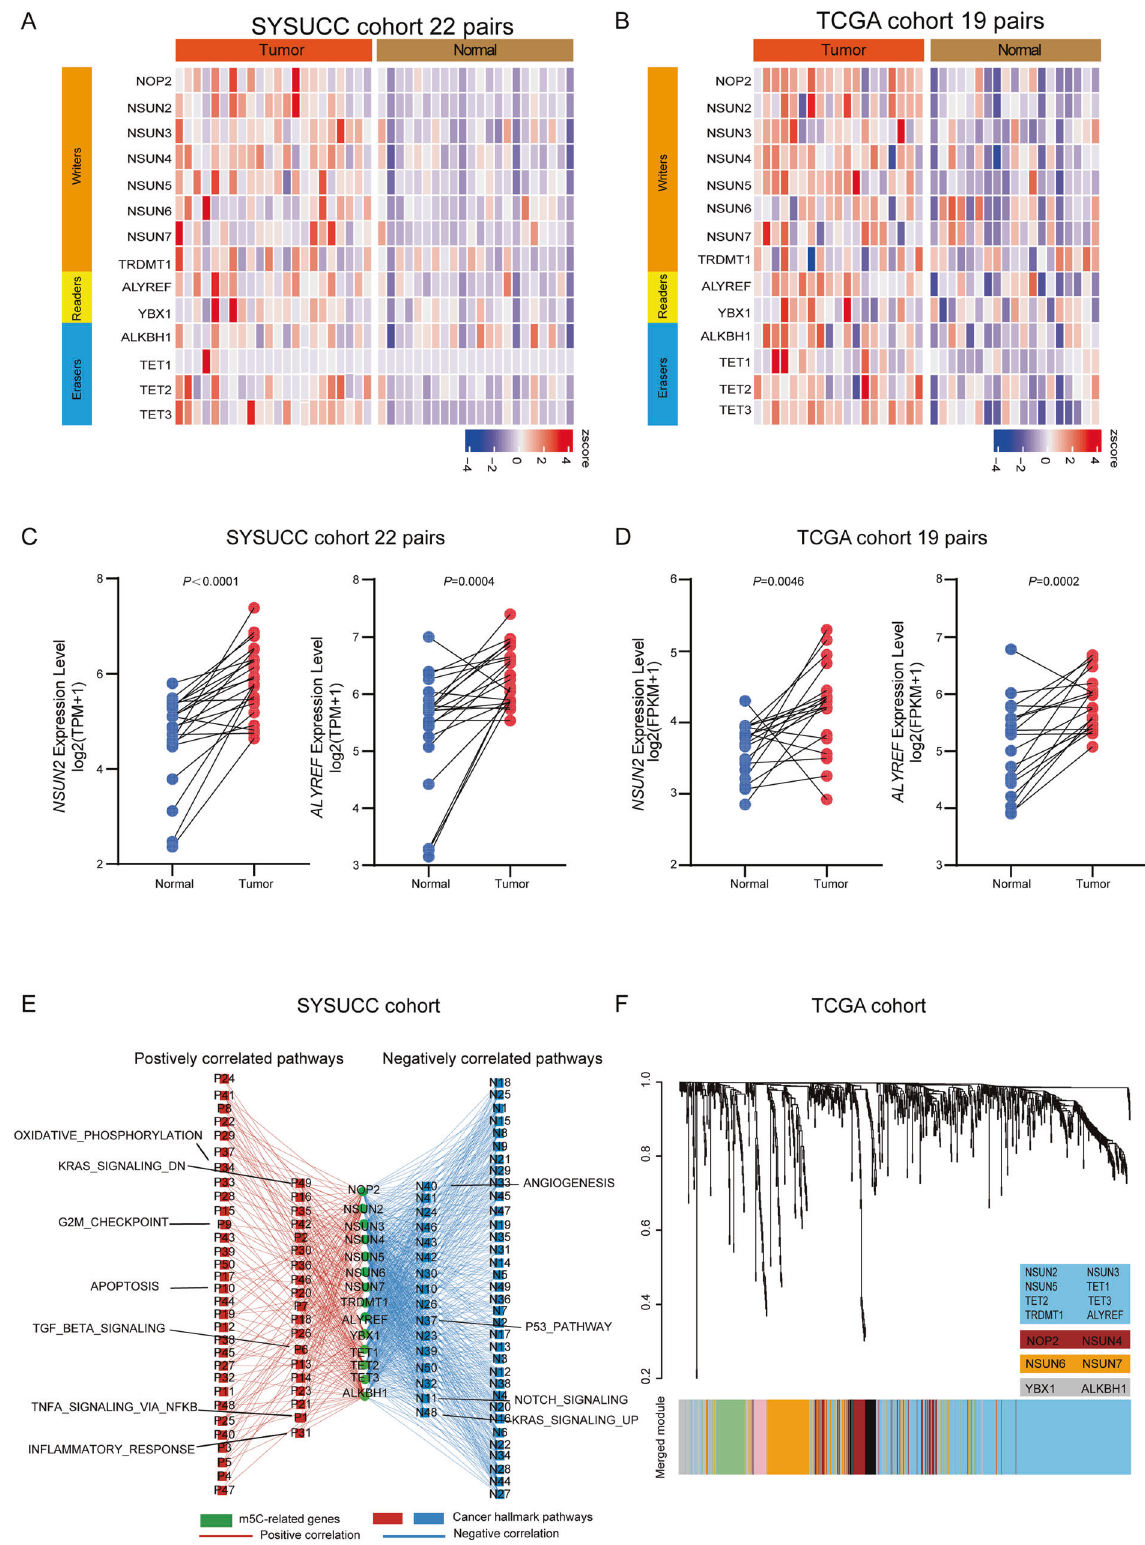
Fig. 1 m 5 C regulators are predominantly upregulated in UCB. A , B Heat maps of m 5 C regulator mRNA expression pro fi les in paired UCB tumor tissues and adjacent normal tissues (22 pairs from SYSUCC cohort [ A ] and 19 pairs from TCGA cohort [ B ]). C , D The expression levels of ALYREF and NSUN2 (fold change > 1.1, P <0.05) in the SYSUCC cohort (22 pairs) ( C ) and TCGA cohort (19 pairs) ( D ). Data represent the mean ± S.D., and a two-tailed paired Student ’ s t -test was applied to determine the P- value. E The signal pathways in which m 5 C regulators may be involved from RNA-seq on SYSUCC UCB cohort. Positive correlations are shown in red; negative correlations are shown in blue. F WGCNA showing the networks among m 5 C regulators in the hierarchical cluster tree.